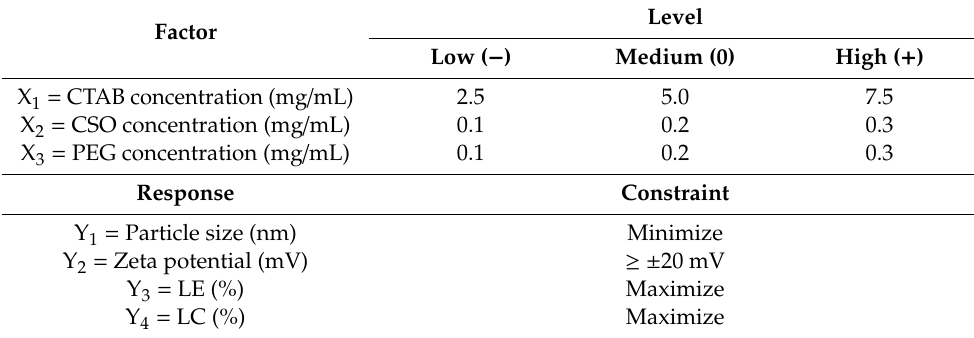
Table 3. Factors and responses of CG-PEG-CSO-SPIONs in the BBD.